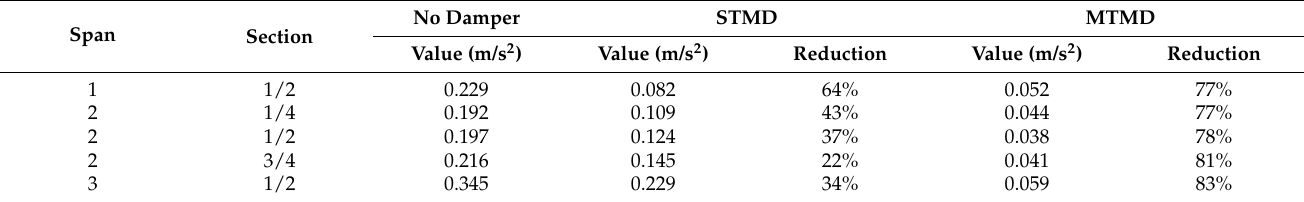
Table 4. Lateral acceleration results of the bridge under load case